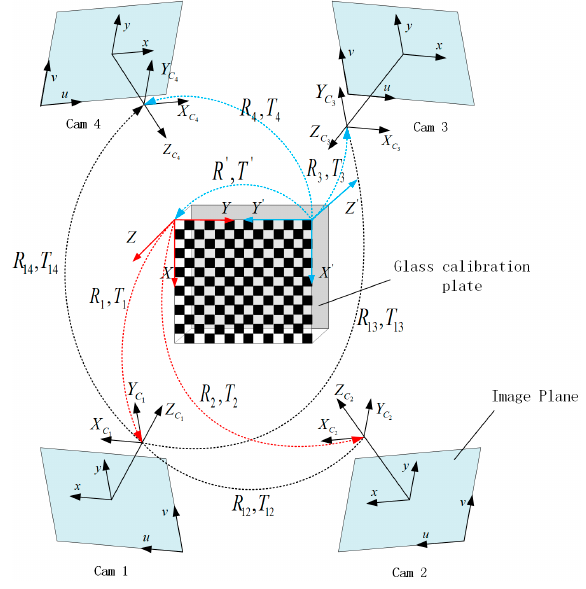
Figure 5. The rotation and translation of the four-camera system.